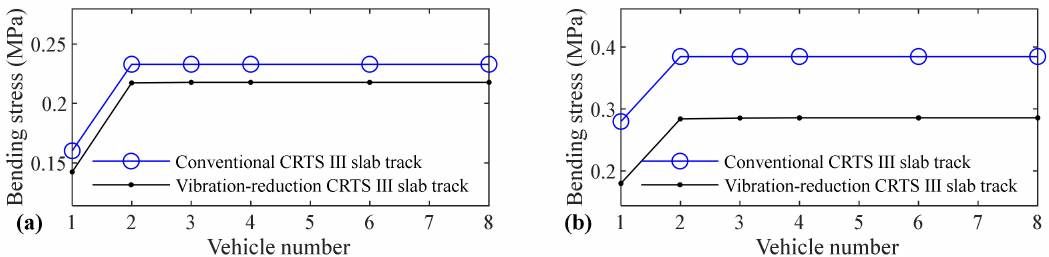
Figure 16. Relation between vehicle number and negative bending stress of concrete base: ( a ) without and ( b ) with random track